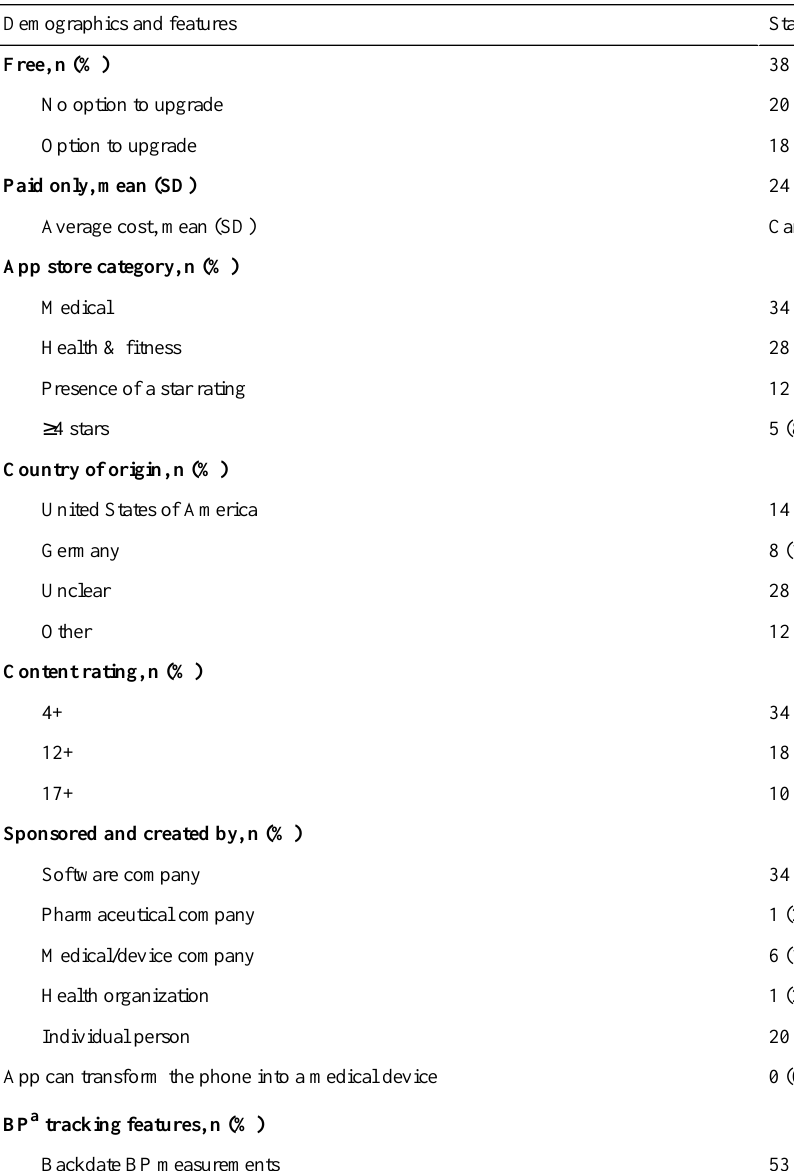
Table 1. Features of the reviewed apps (N=62). StatisticDemographics and